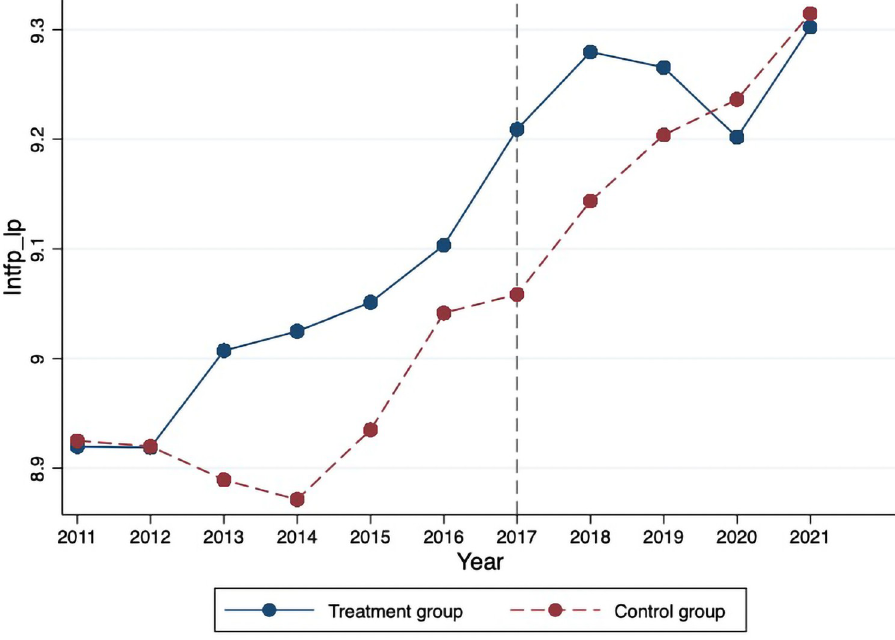
Fig 2. Mean comparison of firm-level between the treatment and control